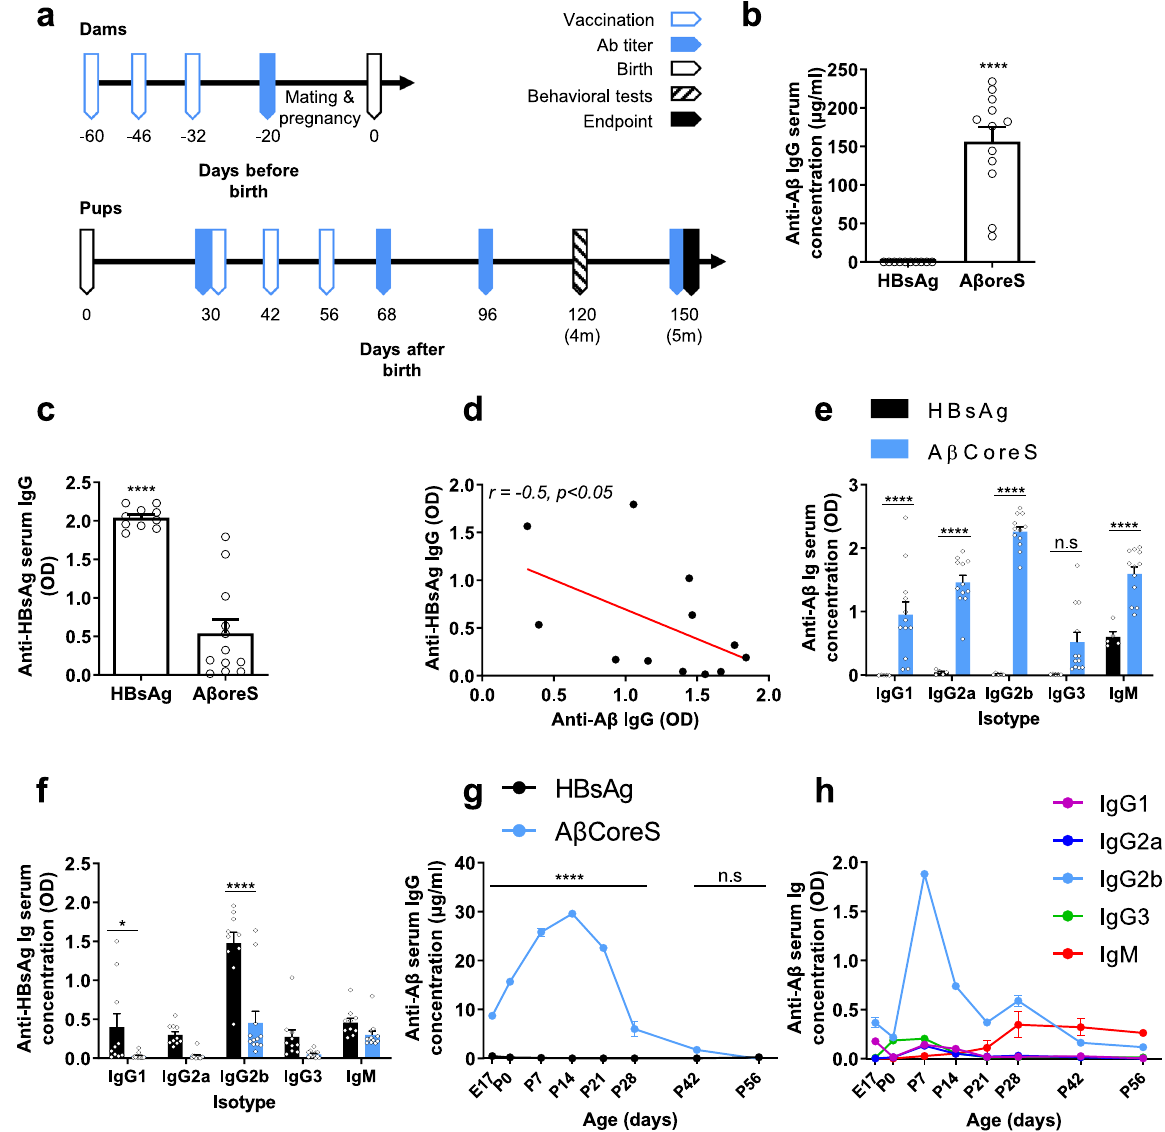
Fig. 1 Maternally induced anti-A β antibodies cross the placenta and lactation into the circulation of 5xFAD fetuses and newborns. a Study design for dams (upper timeline) and pups (bottom timeline). Serum anti-A β antibodies were measured in vaccinated dams ( b – f ), fetuses, and newborns ( g – h ). b Anti-A β IgG titer in A β CoreS ( n = 12 ) and HBsAg ( n = 10 ) vaccinated dams. c Anti-HBsAg IgG titer in A β CoreS and HBsAg vaccinated dams. d A negative correlation between anti-A β IgG and anti-HBsAg IgG in vaccinated dams. e Anti-A β Ig isotypes in A β CoreS and HBsAg vaccinated dams. f Anti- HBsAg Ig isotypes in A β CoreS and HBsAg vaccinated dams. g Maternally induced anti-A β Abs cross the placenta and lactation to the circulation of fetuses and newborns. h IgG2b is the most transferable isotype via the placenta and lactation. * P < 0.05, **** P < 0.0001, unpaired t -test, linear